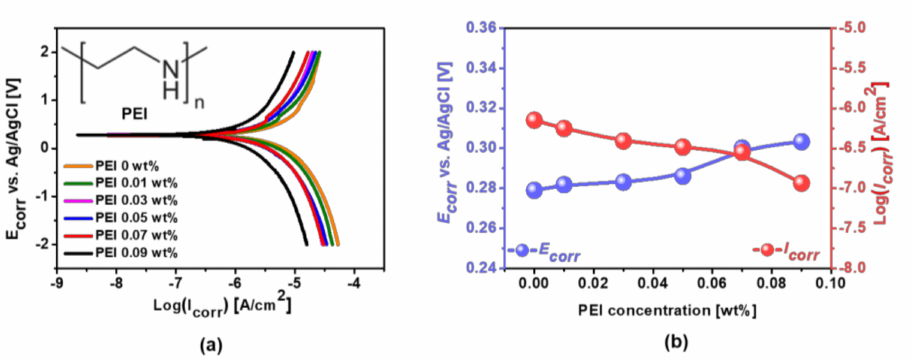
Figure 6. Dependency of corrosion degree of Ge 1 Sb 4 Te 5 film surface on corrosion inhibitor (i.e., PEI) concentration after dipping of Ge 1 Sb 4 Te 5 film surface into slurries. ( a ) Potentiodynamic polarization curve of Ge 1 Sb 4 Te 5 film surface as a function of corrosion inhibitor concentration. ( b ) Dependencies of corrosion potential ( E corr ) vs. corrosion current density ( I corr ) on corrosion inhibitor